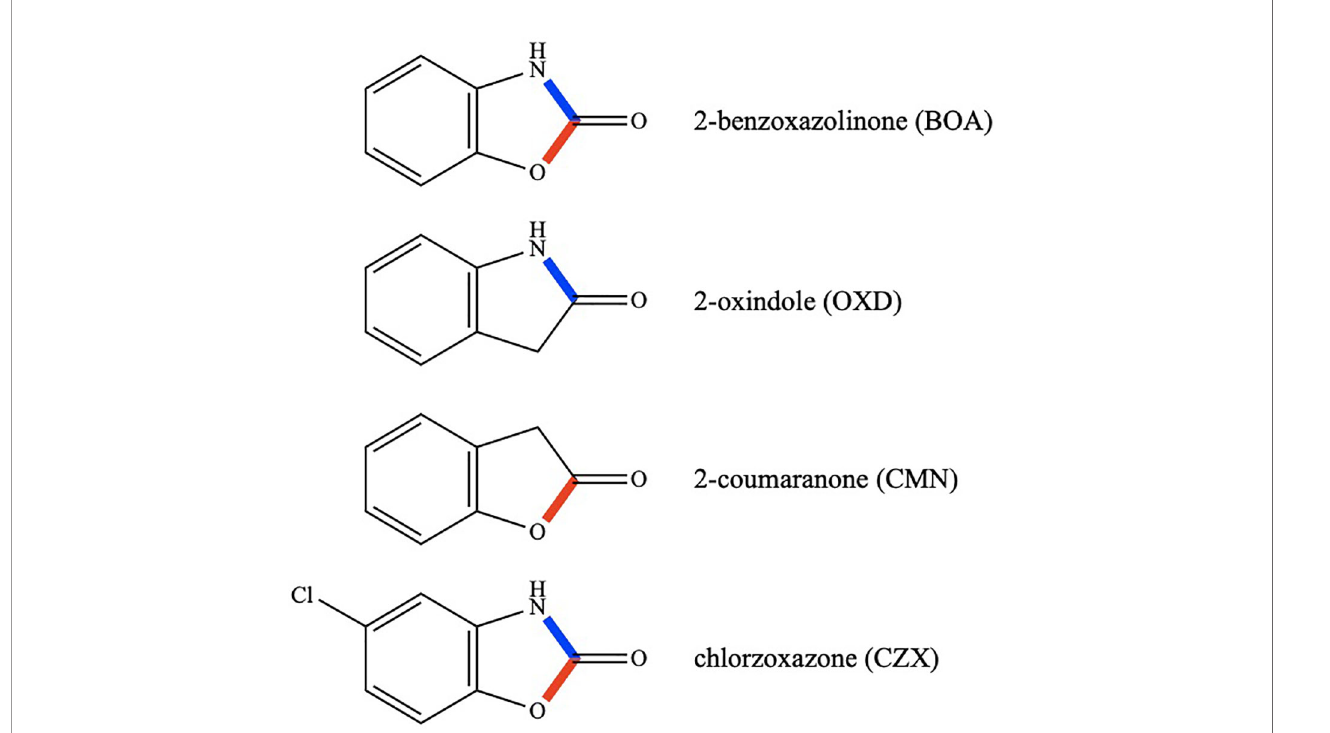
FIGURE 1 | Chemical structures of BOA, OXD, CMN, and CZX. Lactam bonds are shown in blue and lactone bonds in